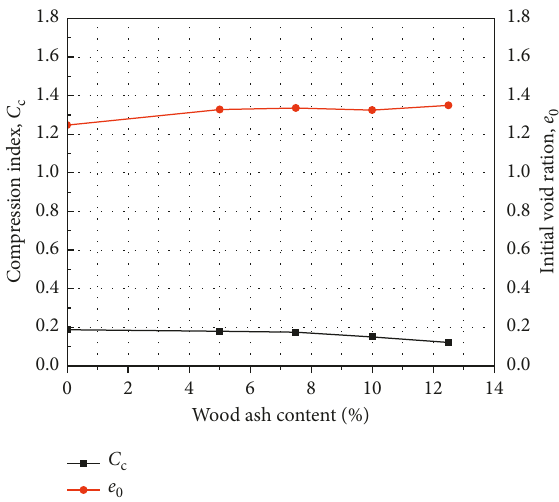
Figure 9: Variation of the initial void ratio ( e index ( C c ) with ash content.